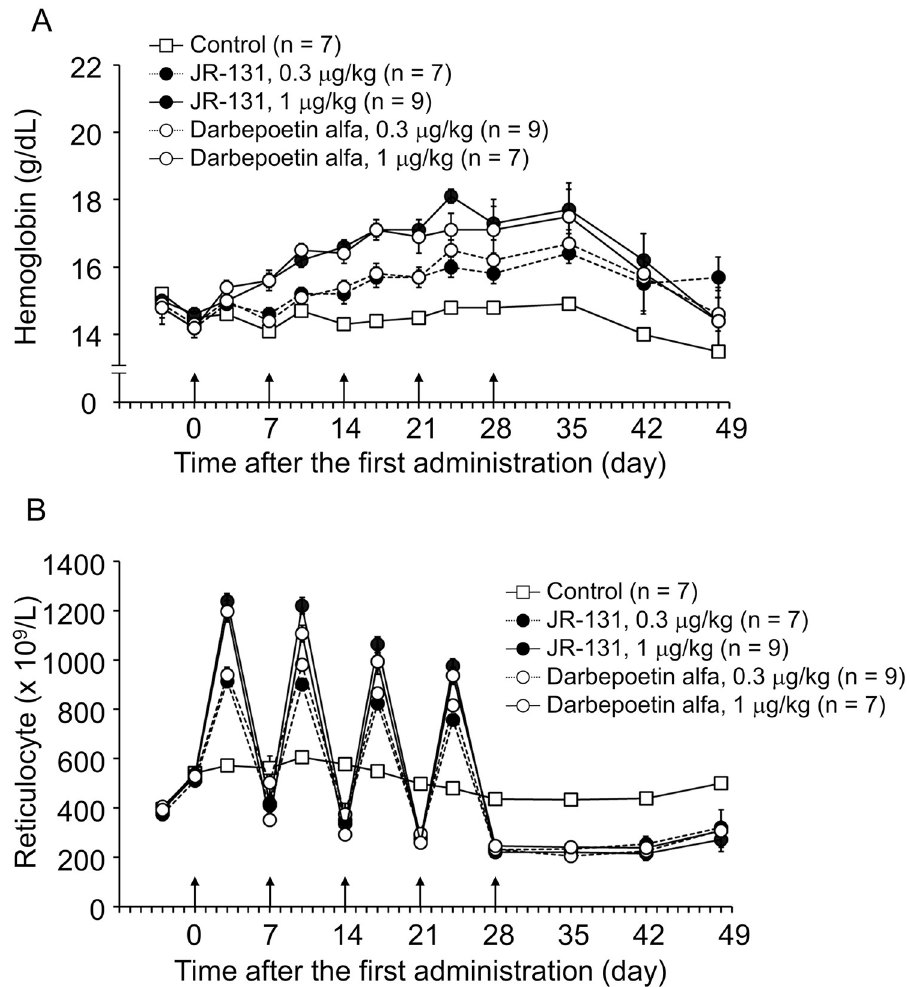
Fig 9. In vivo efficacy assay in 5/6 nephrectomized rats. The erythropoiesis-stimulating activity of the test substances was examined using an animal model of renal anemia. (A) Hemoglobin concentration and (B) reticulocyte number are shown. Arrows indicate the timing of drug administration. Data are represented as means with standard error bars. The numbers of animals are indicated in each